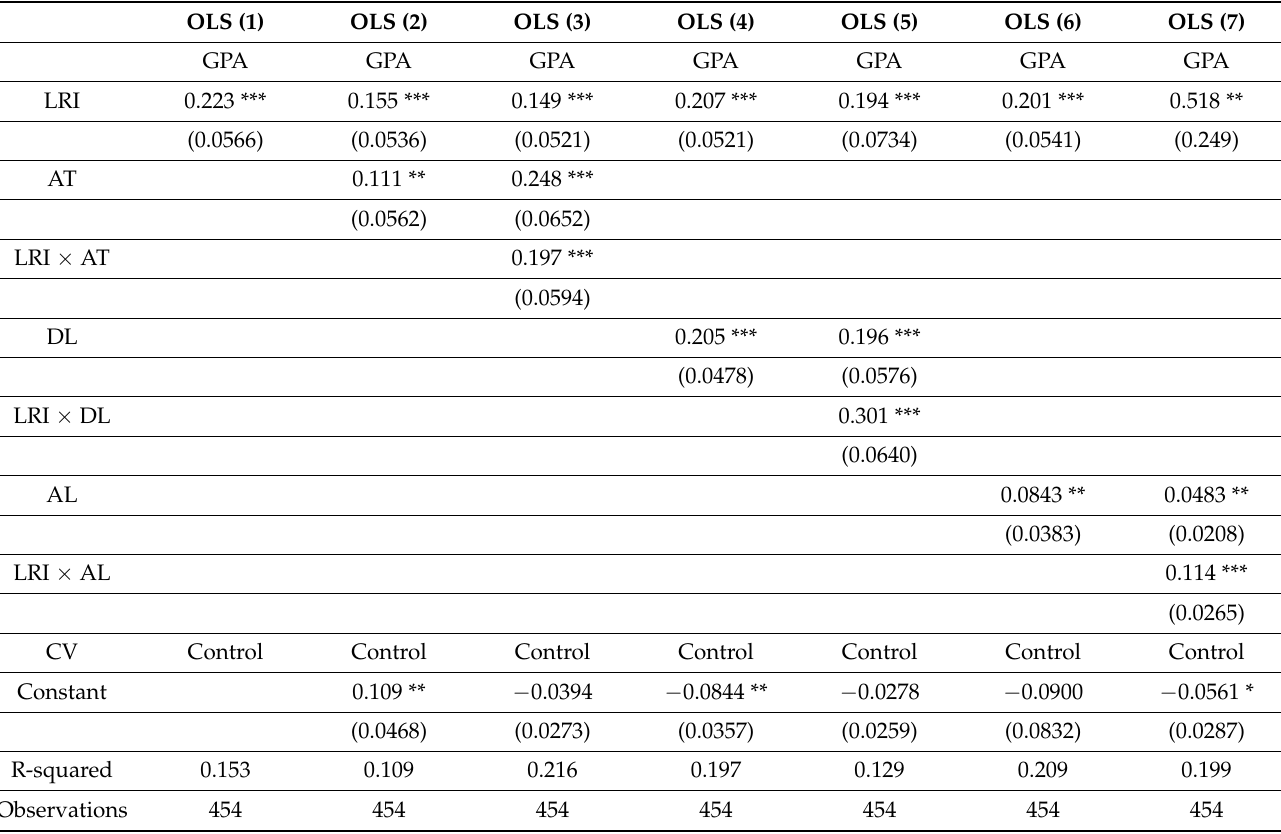
Table 8. Mechanistic analysis of the effect of LRI on GPA: moderating effect test of AT, DL and